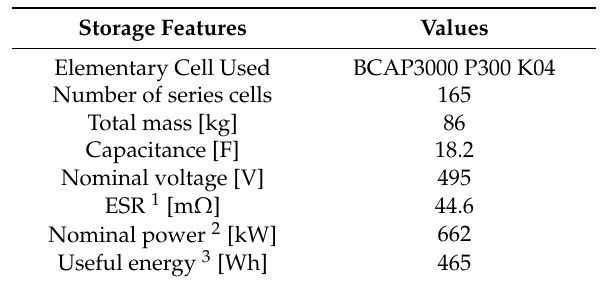
Table 4. Supercapacitor storage